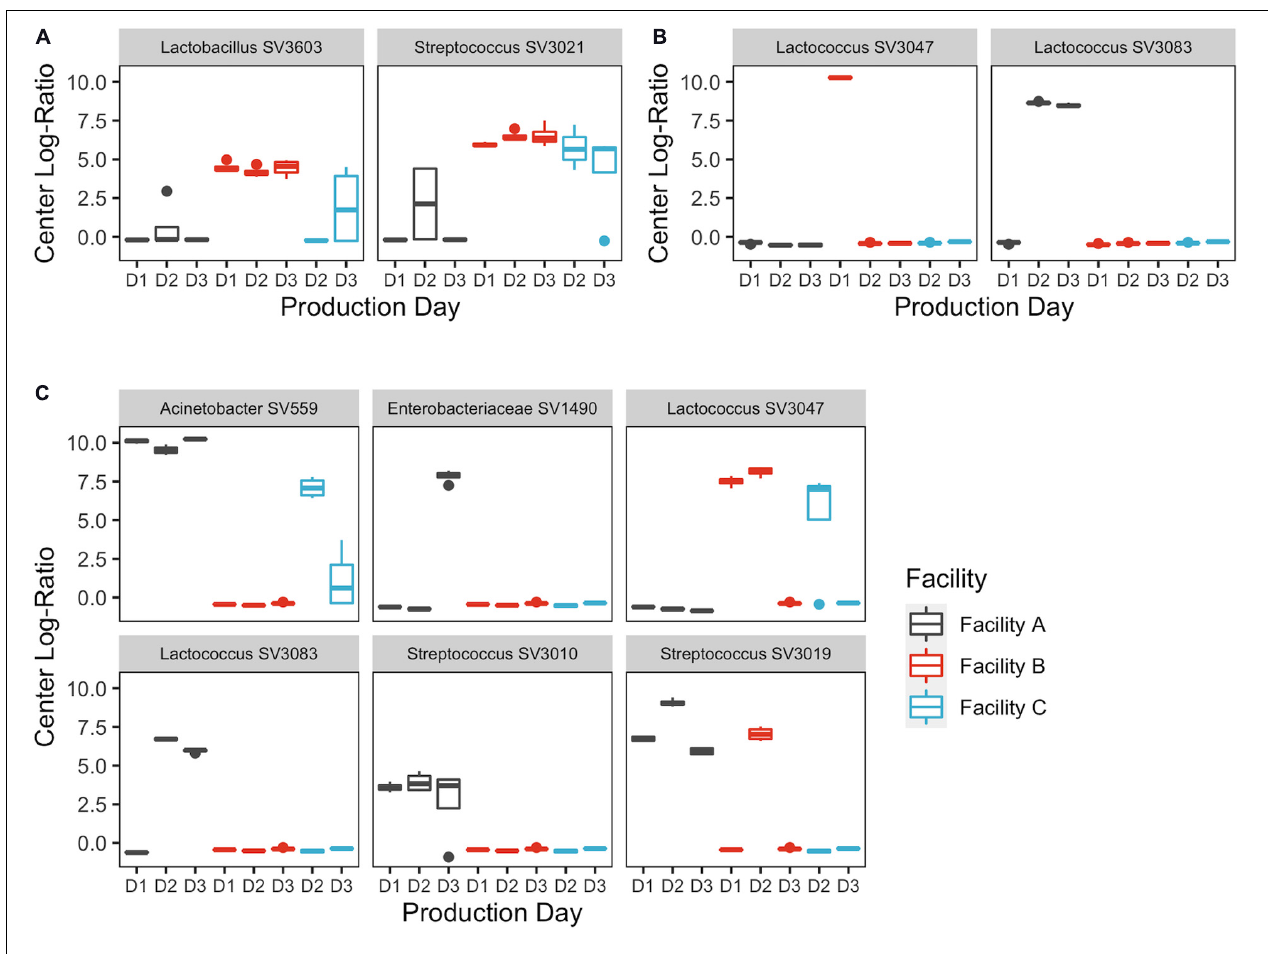
FIGURE 6 | Centered log-ratios of SVs that explained ≥ 5% of the variance in the first component of the (A) thermized milk, (B) pressed cheese, and (C) upper DMC belt principle component analyses. Bars are colored by cheesemaking facility. Repeat sampling days within each facility are displayed across the x